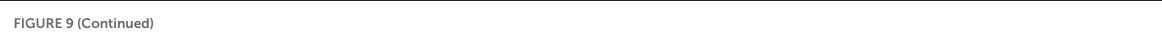
FIGURE9(Continued) EM control groups analyzed on Day 7 p.i. Arrows indicate lymphoid tissue infiltration (red), oocysts (black), connective tissue proliferation (green), oocyst proliferation in the glandular cavity (yellow), heterophilic granulocyte infiltration (purple), submucosal damage and inflammatory cell infiltration (blue), necrotic tissue and cell fragments (orange), and eosinophilic enhancement (white). A3 and A1 represent EM treatment 3 days before and 1 day after ET infection, respectively. EM, extract and essential oil mixture (non-toxic concentrations of Punica granatum L.,